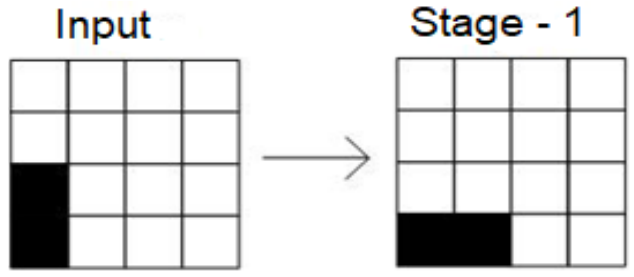
Figure 5. Improved version of the initial filling of the data set.